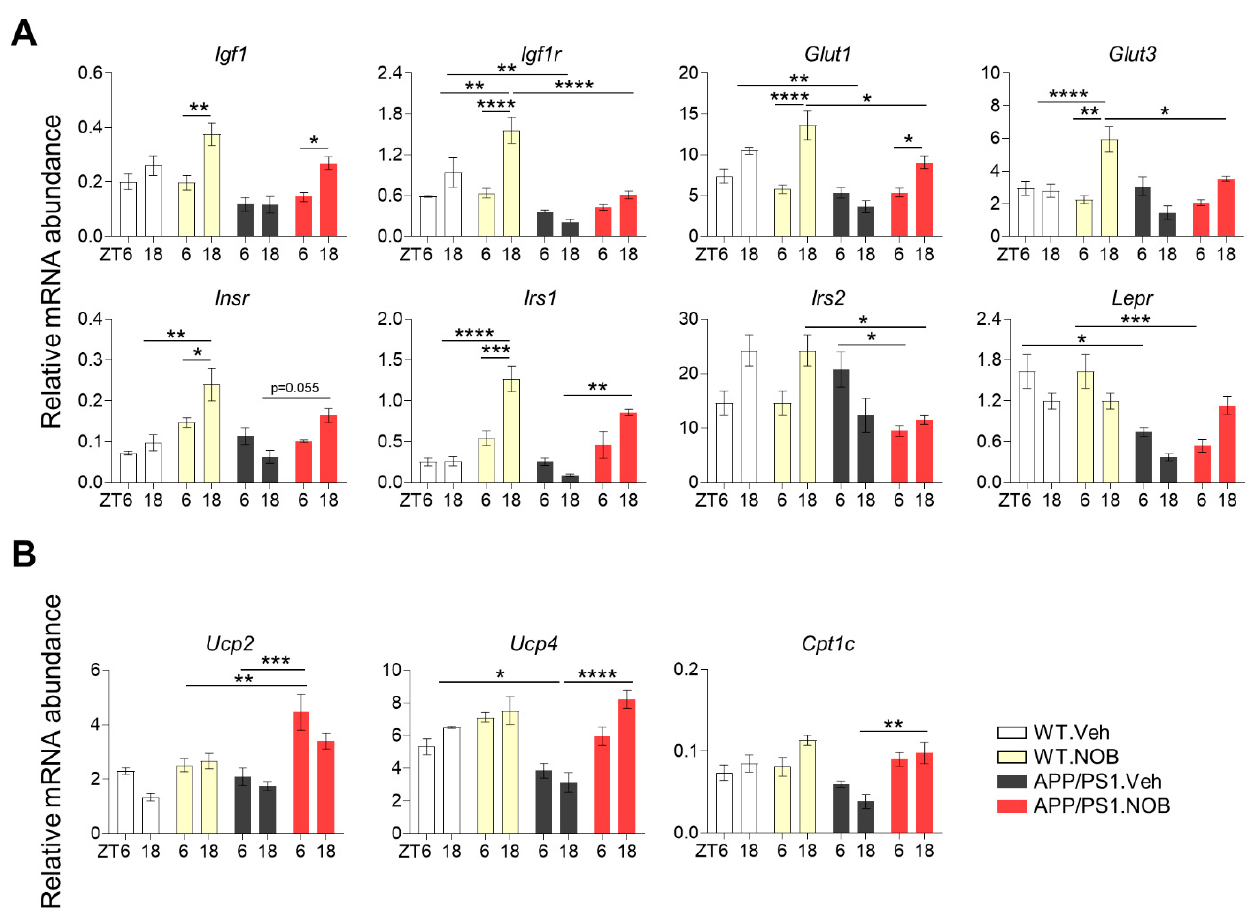
Figure 4. Nobiletin alters metabolic and mitochondrial gene expression in APP/PS1 mice. mRNA expression of ( A ) insulin signaling and glucose transporter-related genes and ( B ) mitochondrial thermogenic genes in cortex tissues was measured using real-time qPCR (n ≥ 3/each group). Mice were sacrificed at ZT6 and ZT18 under the LD condition. Data represented by mean ± SEM in bar graph. * p < 0.05, ** p < 0.01, *** p < 0.001, **** p < 0.0001, two-way ANOVA with Tukey’s multiple comparisons.